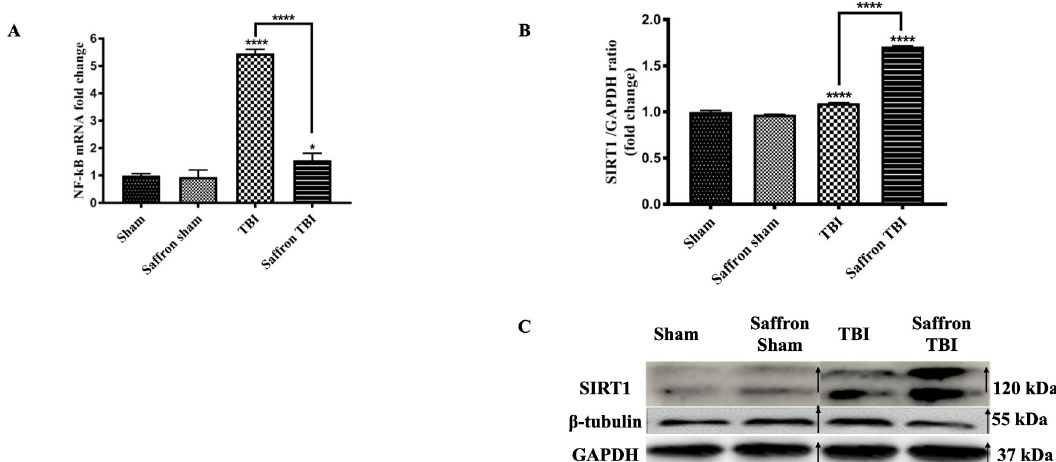
Fig 6. Effect of saffron extract on NF– κ B and SIRT 1. (A) show the mRNA fold–change of NF– κ B and (B) shows SIRT1 protein expression level relative to GAPDH. (C) is a composite representative western blot image of bands originating from different blots SIRT 1, GAPDH, and β –tubulin in which bands of the TBI group and saffron TBI group were spliced from the same original image and re–ordered to be coherent as described in material and methods as samples were loaded differently, and with β –tubulin and GAPDH as controls, 24 hours post the final injury. The arrow signs show the spliced and rearranged bands. Data are mean ± SEM of 9 mice per group. ( � ), ( ���� ) represent P < 0.05 and P < 0.0001.